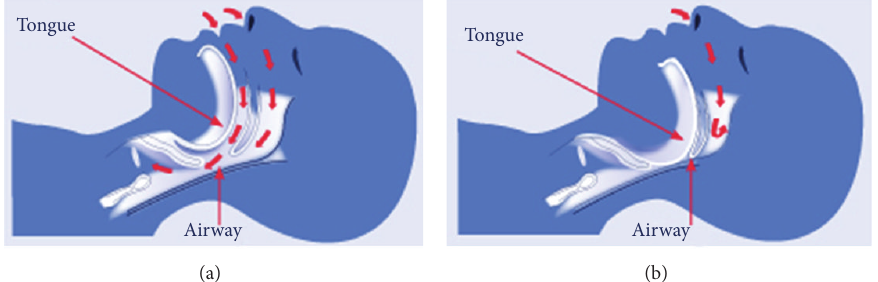
Figure 1: Mechanism of airway obstruction in OSA. (a) demonstrates normal breathing; (b) shows posterior movement of the tongue producing OSA.